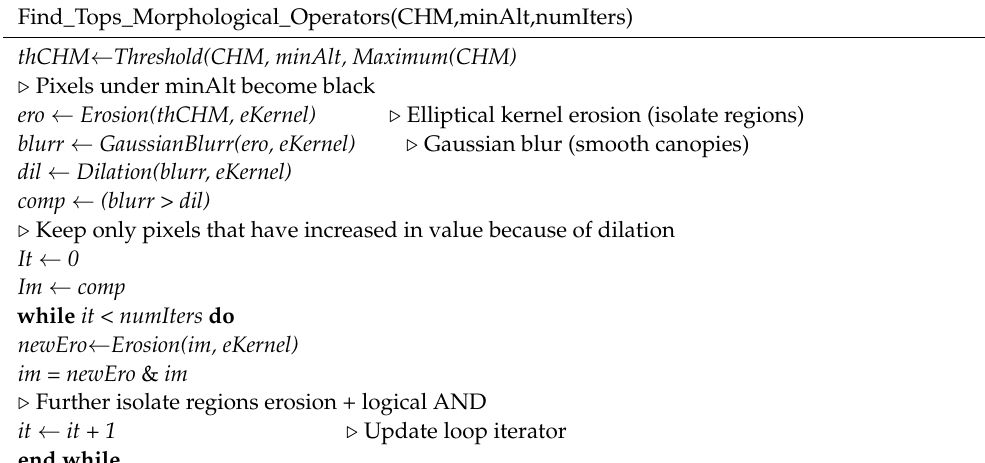
Algorithm 2. Morphological operation and treetop detection